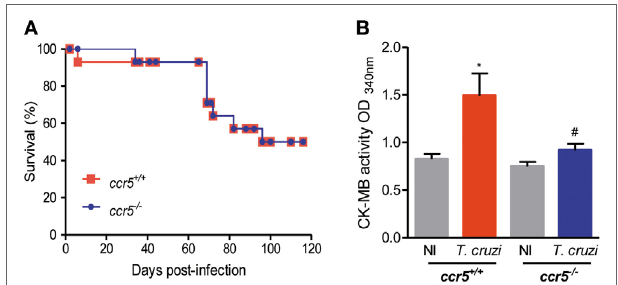
FigUre 3 | Effects of CCR5 deficiency on survival and myocardial injury in T. cruzi -infected mice. Mice were infected with 1,000 trypomastigote forms of the Colombian T. cruzi strain and analyzed at 70 days postinfection. (a) Survival curves of T. cruzi -infected Ccr5 + / + and Ccr5 − / − mice. Deaths were registered weekly. (B) Sera were collected, and CK-MB activity was determined by biochemical assay. Data represent two independent experiments with three noninfected (NI) and five to seven infected mice [* P < 0.05, T. cruzi -infected Ccr5 + / + mice vs NI; # P < 0.05, Ccr5 − / − vs Ccr5 + / + T. cruzi -infected mice (analysis of variance, Bonferroni